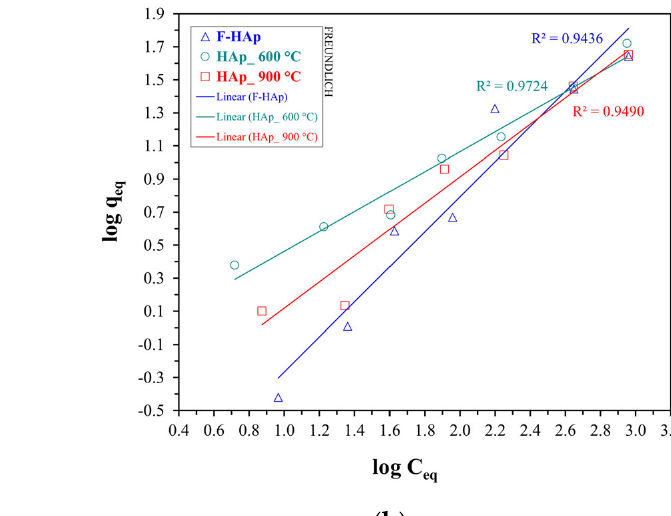
Table 7. Calculated Langmuir and Freundlich isotherm model parameters for all adsorbents (F − HAp, HAp_600 °C, and HAp_900 °C) and pollutants (atrazine and cobalt).